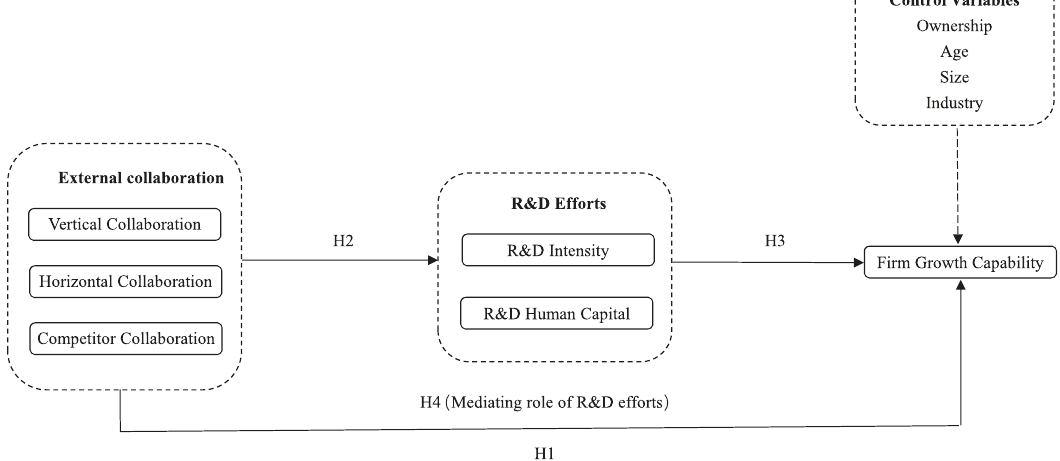
Fig. 1 Conceptual framework. The H1, H2, H3, and H4 marked by solid arrows are the hypotheses proposed in the Section “ Hypotheses development ” . The dotted arrow indicates the effects of control variables which are not highlighted in the